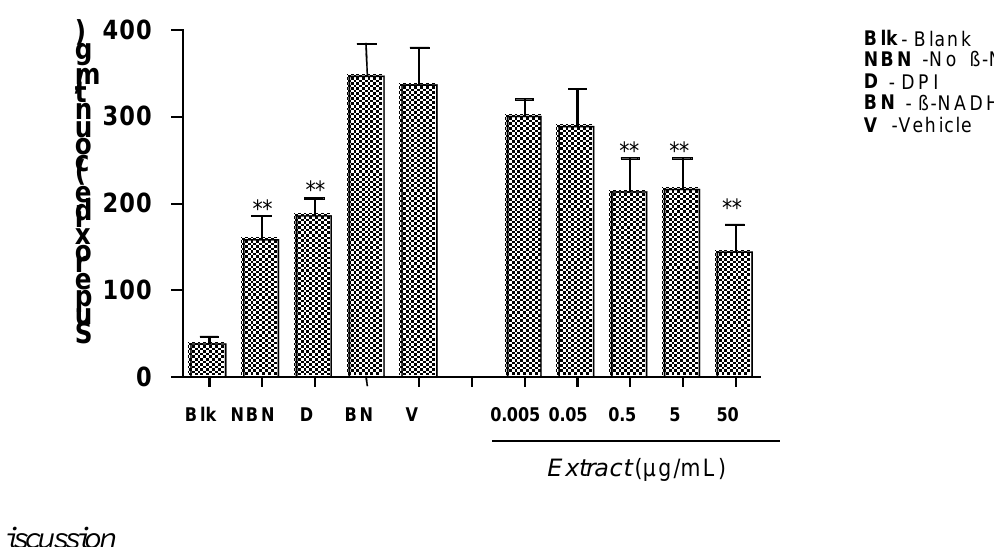
Figure 5. Effect of various concentration of P.grandis (stem bark) methanolic extract on superoxide production induced by β -NADH in rat aortic rings detected by chemilunescence assay. Results are mean ± S.E.M (n = 5–7). Significant difference from vehicle control is indicated by ** (p <